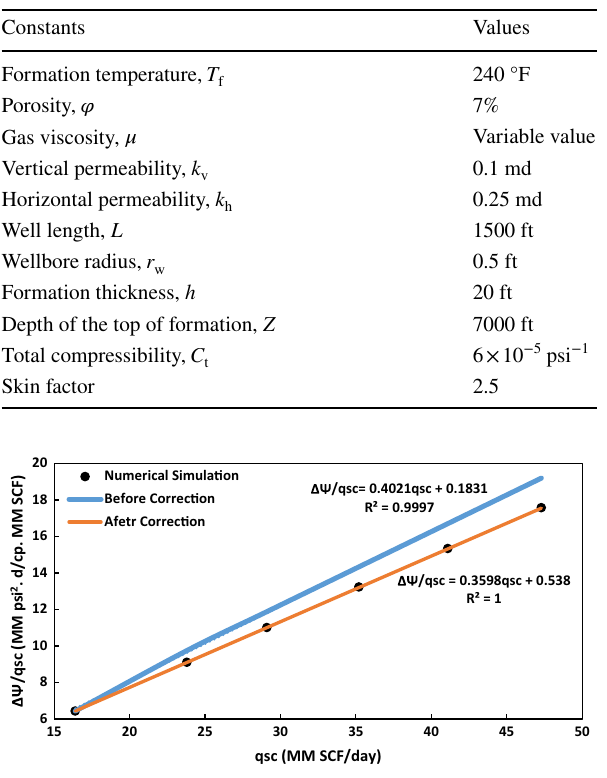
Fig. 6 Productivity analysis of horizontal well #1 using pseudo-pres- sure rate per rate vs. rate